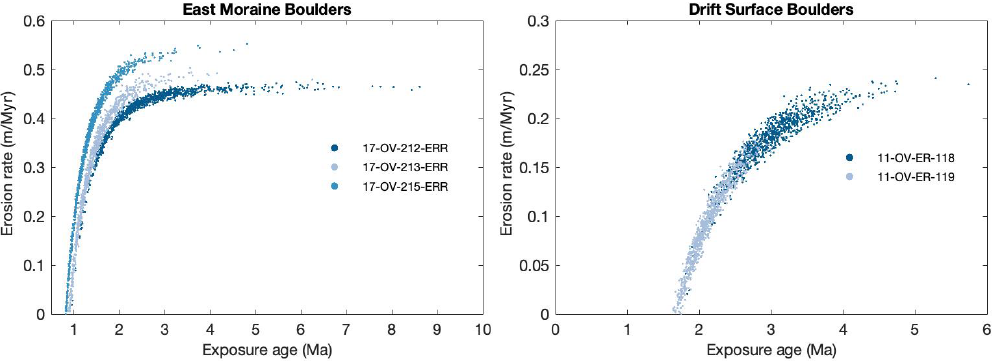
Figure 12. Exposure ages and erosion rates for the Middle drift surface and moraine